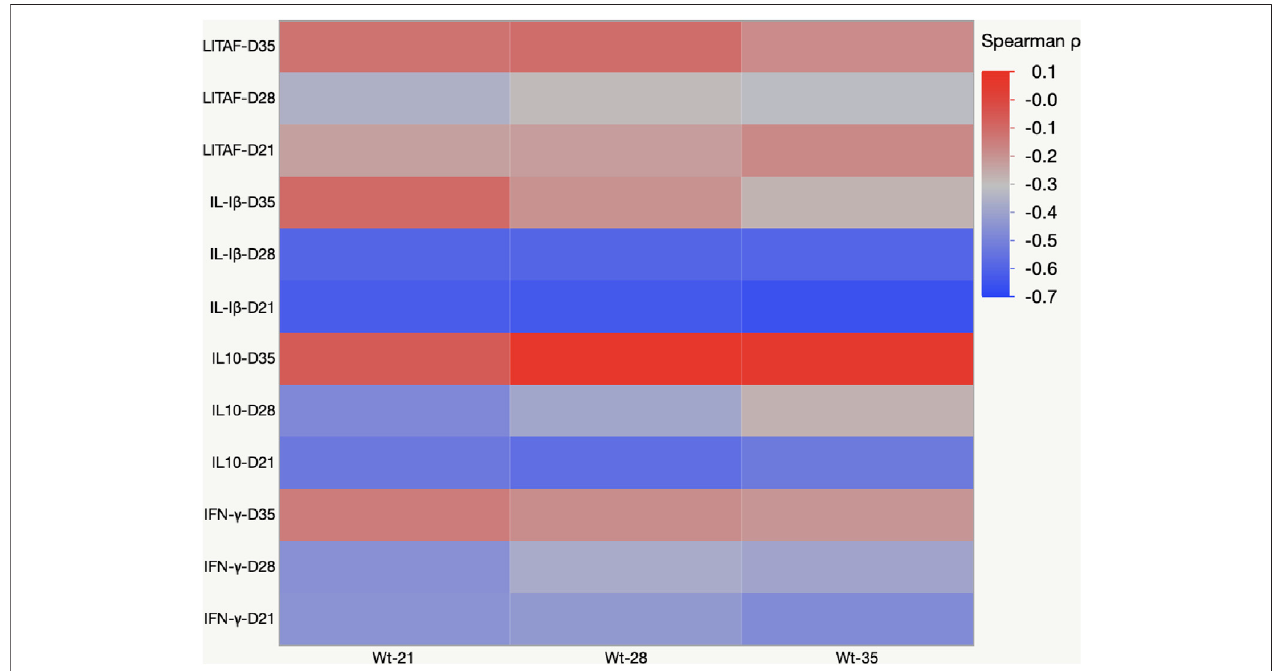
FIGURE 8 | Heat map representing Pearson ’ s r correlation coef fi cient matrix between cytokine amounts and body weight gain. Heat map showing the transcriptional fold change of LITAF, IL-1 β , IL-10, and IFN- γ in the cecal tonsils of birds fed mycotoxin contaminated diet and induced with necrotic enteritis. The color scale, − 1 (blue) to +1 (red), and the negative value of the coef fi cient indicate that increased IL-1 β and IL-10 mRNA expression levels are inversely affected the body weight.